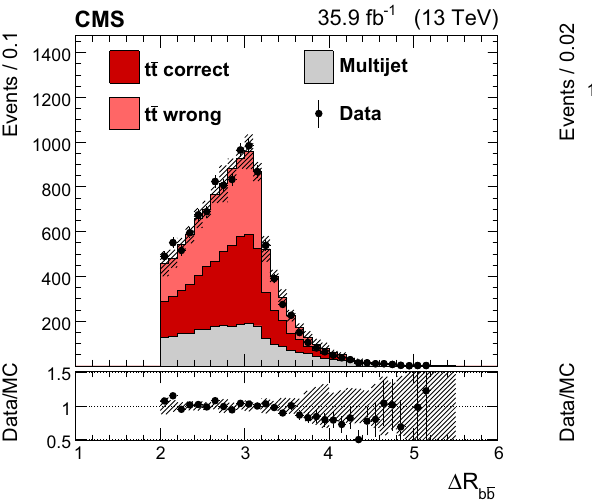
are normalized to the integrated luminosity. For the background esti- mate, the total normalization is given by the difference of observed data events and expected signal events. The hashed bands represent the total uncertainty in the complete prediction. The lower panels show the ratio of data and